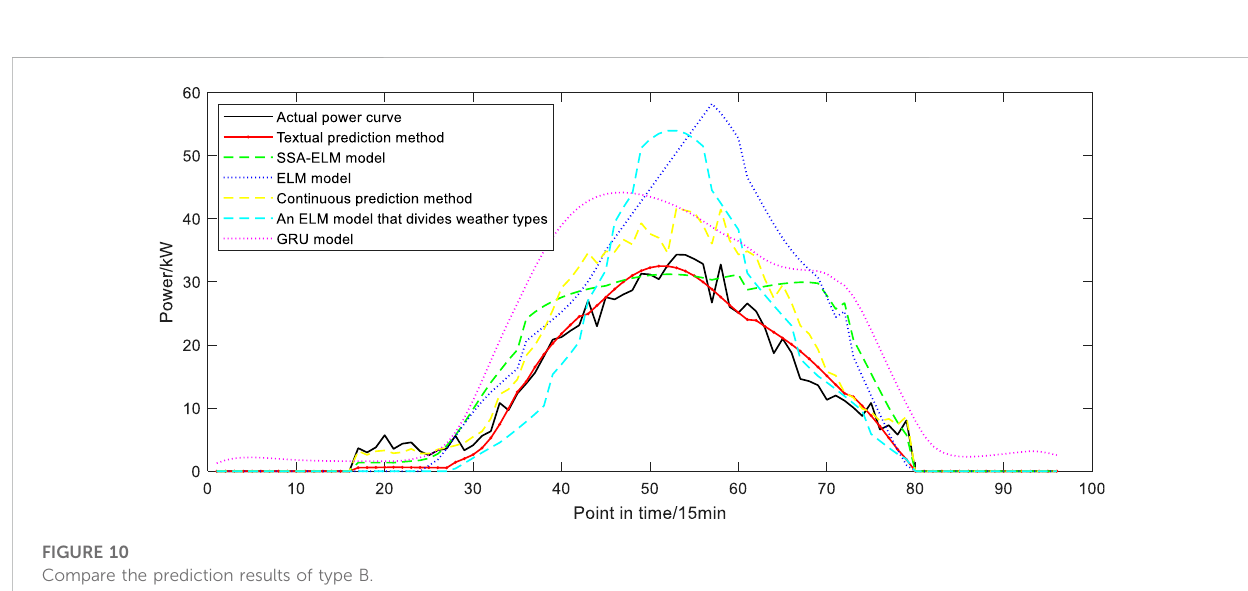
FIGURE 9 Compare the prediction results of type